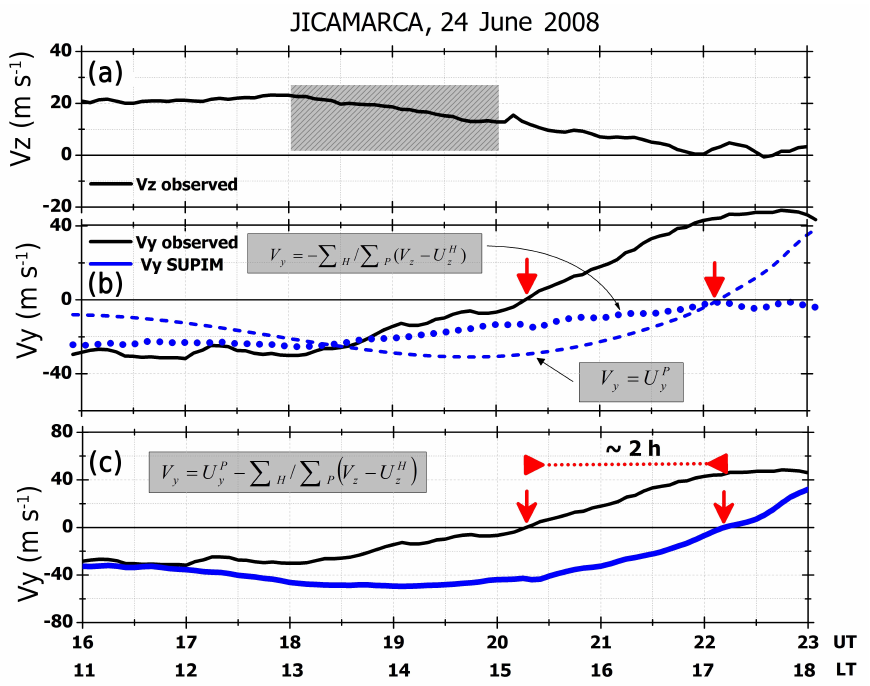
Figure 2. (a) The measured vertical and (b, c) zonal plasma drifts during 24 June 2008. The calculated zonal drifts for different conditions are also presented as dotted and dashed blue curves in panel (b) and solid blue curve in panel (c) . The solid black curves in panels (b, c) are the observed zonal drift. The shaded area and the red arrows indicate some important points that are discussed in the